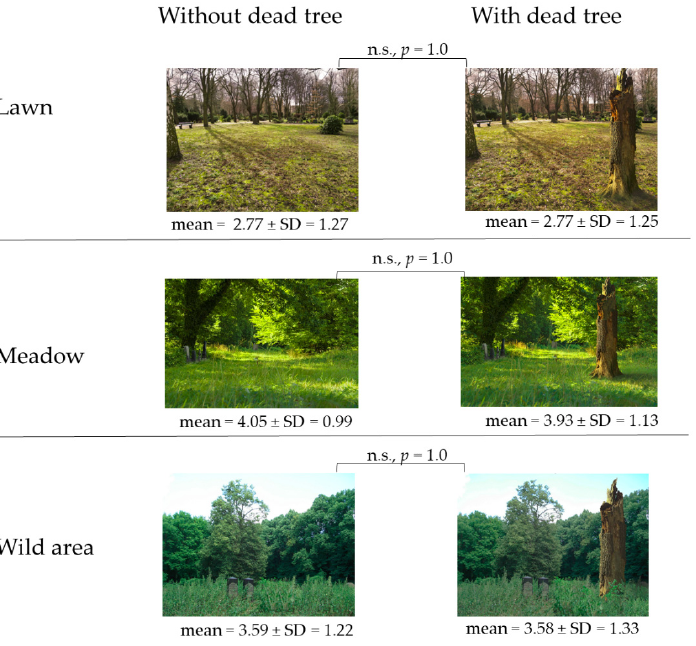
Figure 1. Average preference rating and standard deviation (SD) for differently managed cemetery spaces (lawn, meadow, wild area) without (left ) and with ( right ) an inserted dead tree (n.s. = not significant).